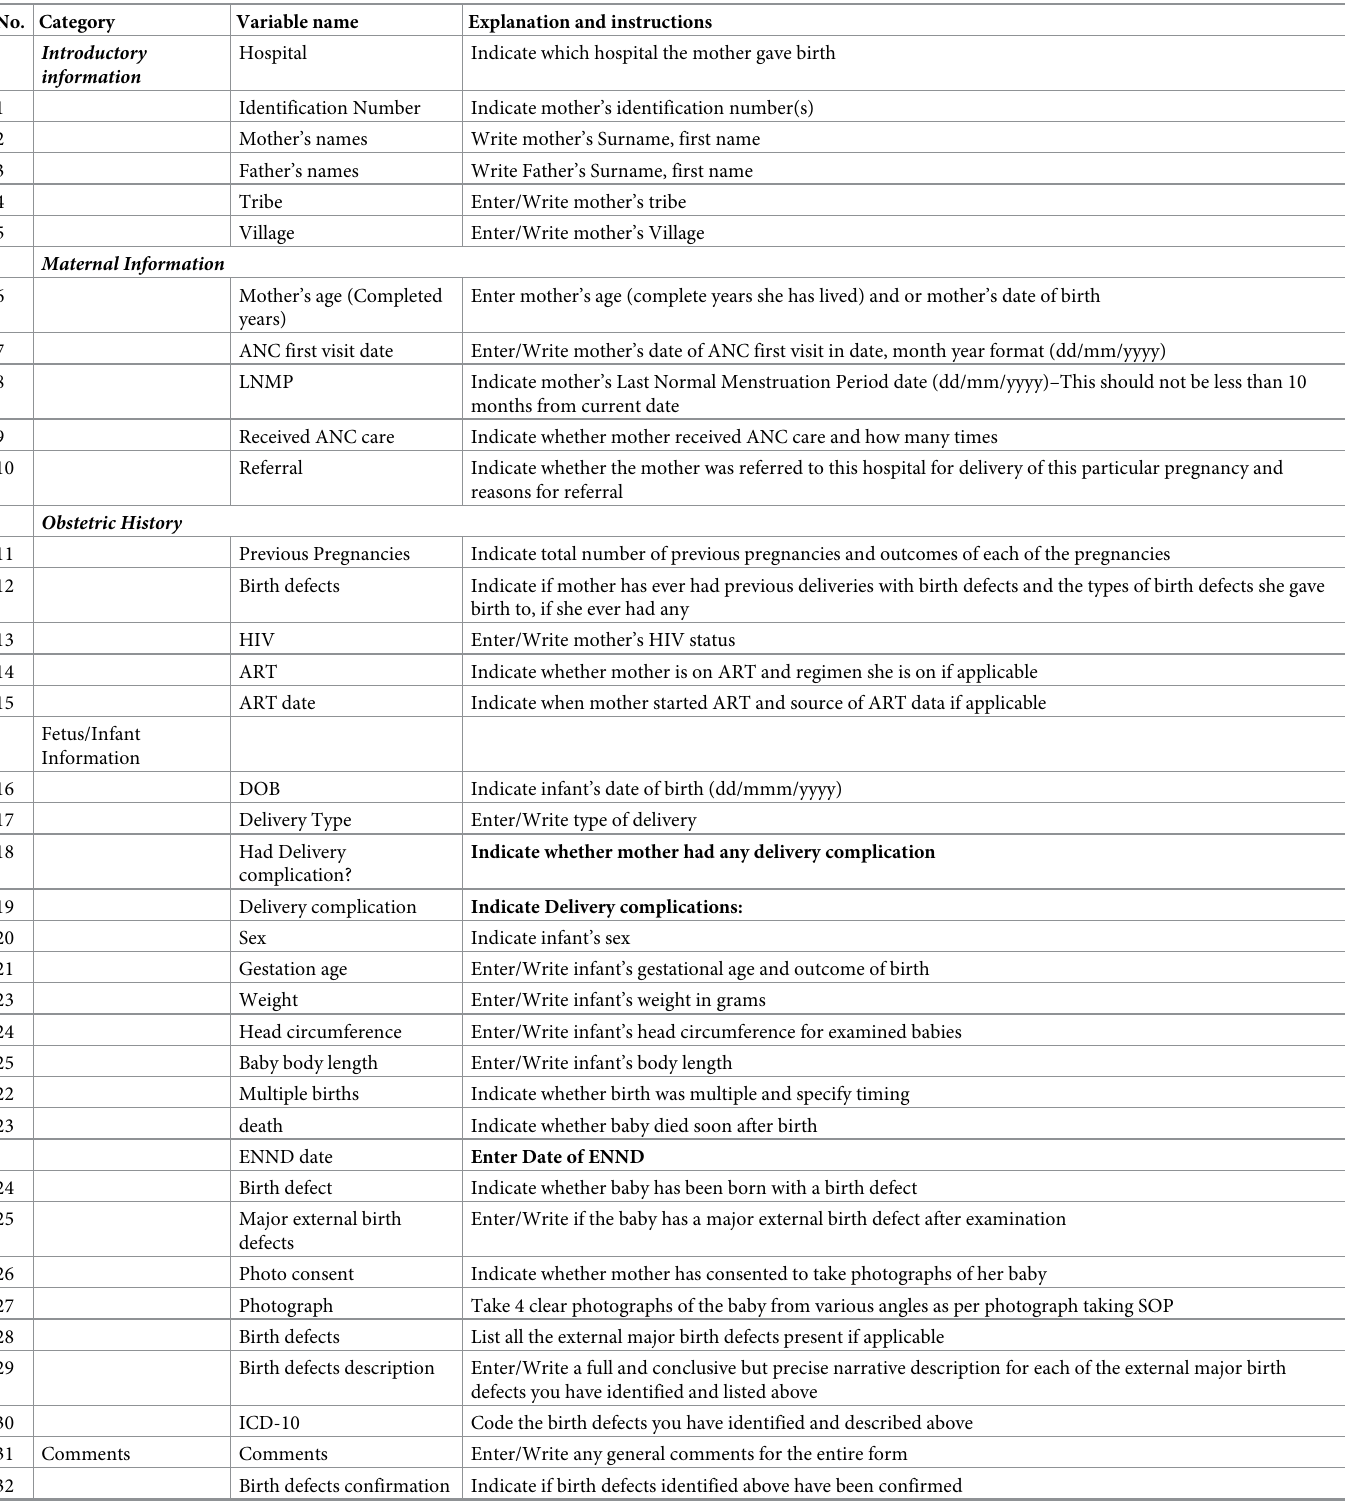
Table 1. List of data collected by